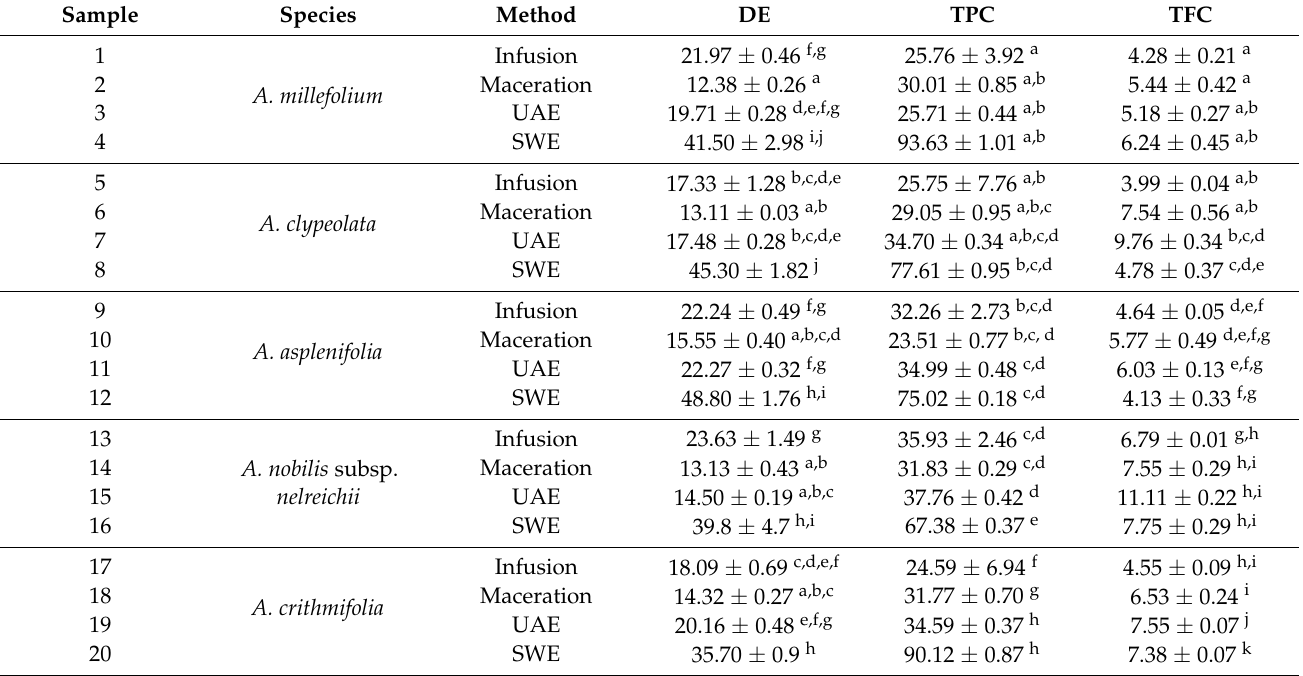
Table 1. Preliminary chemical characterization of Achillea sp. extracts obtained by conventional methods (infusion and maceration) and non-conventional methods (UAE and